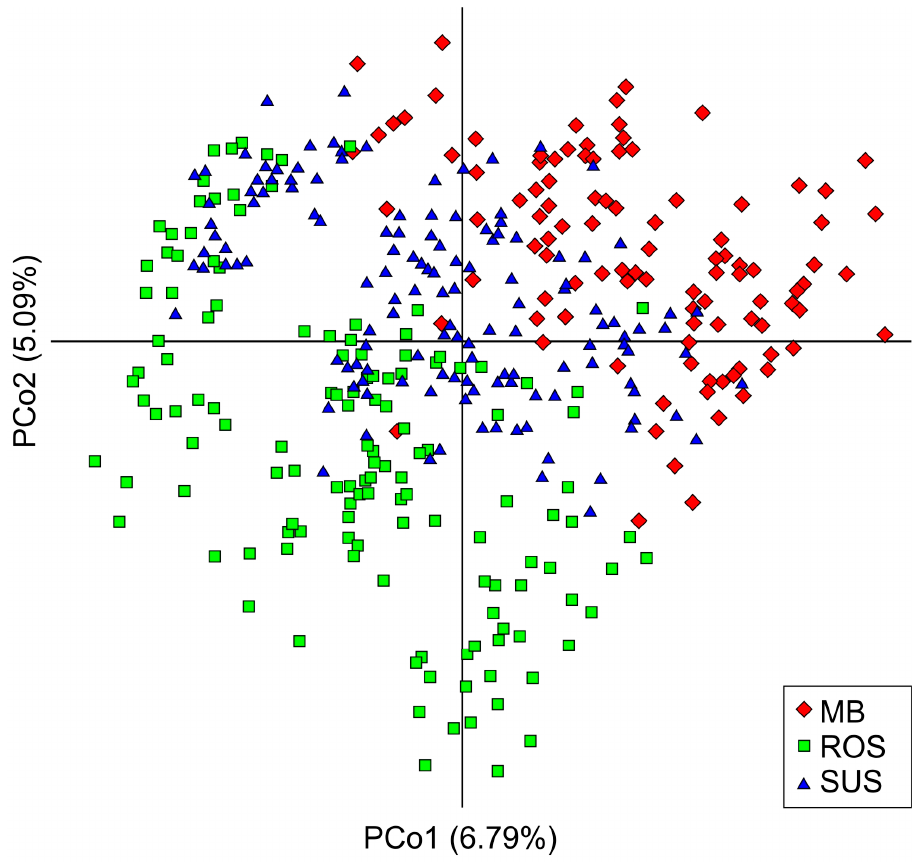
Figure 2. Principal coordinates analysis (PCoA) representing genetic distances between B. humilis individuals from the MB, ROS, and SUS populations.